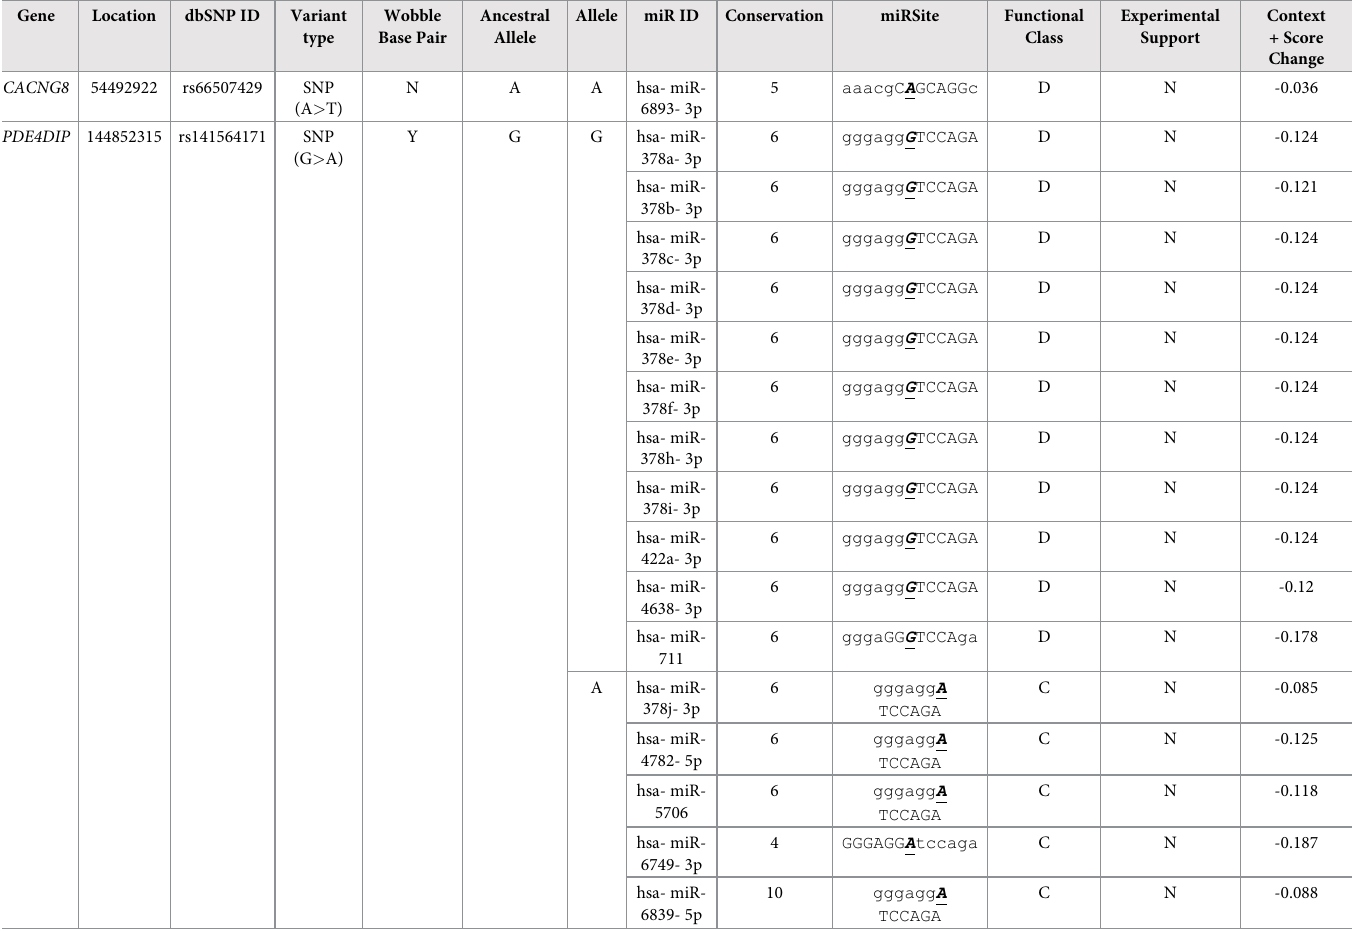
Table 3. PolymiRTS analysis of miRNAs potentially altered target sites associated with the reported candidate variants. Gene